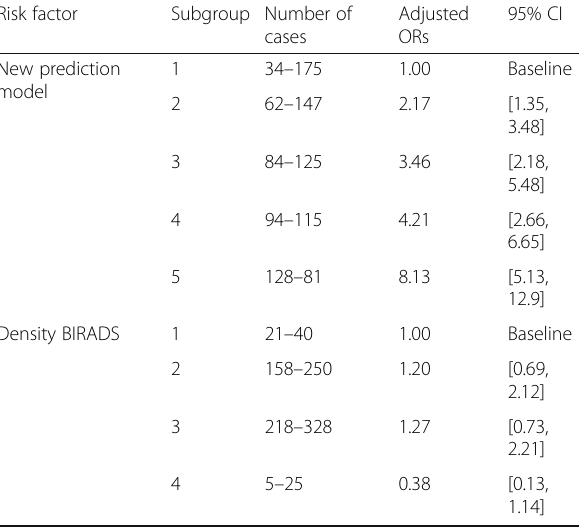
Table 1 Comparison of the adjusted odds ratios (OR) and 95% CIs between the new model-generated risk scores and mammographic density ratings by the radiologists Risk